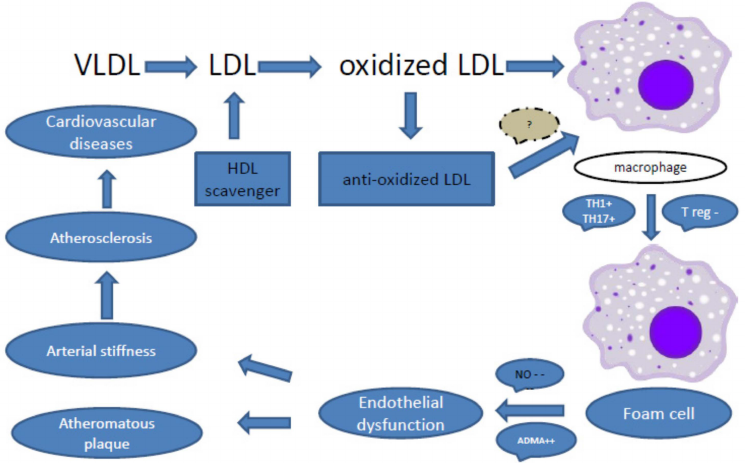
Figure 3. Pathogenesis of atherosclerosis based on possible association with immune changes accompanying inflammation. Legend: VLDL: very-low-density lipoprotein; LDL: low-density lipoprotein; HDL: high-density lipoprotein; TH1: T helper cell 1; TH17: T helper 17; T reg: T regulator cells; NO: nitric oxide; ADMA: asymmetric dimethylarginine; ++ stimulate; −−